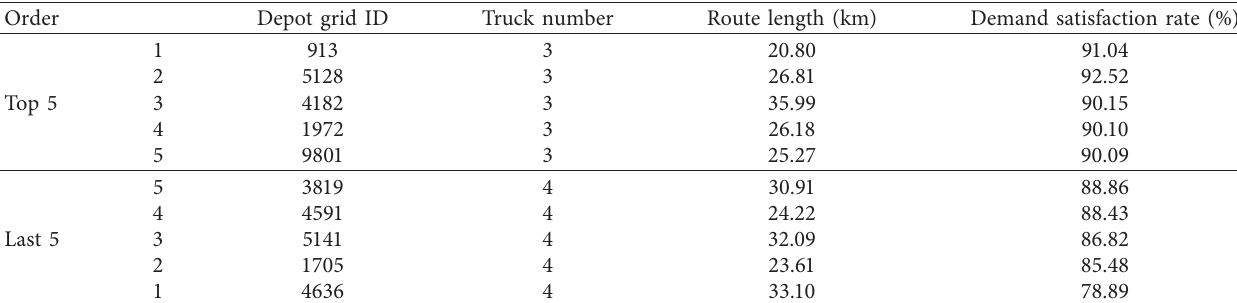
Table 5: The corresponding values of the top 5 and the last 5 dispatch